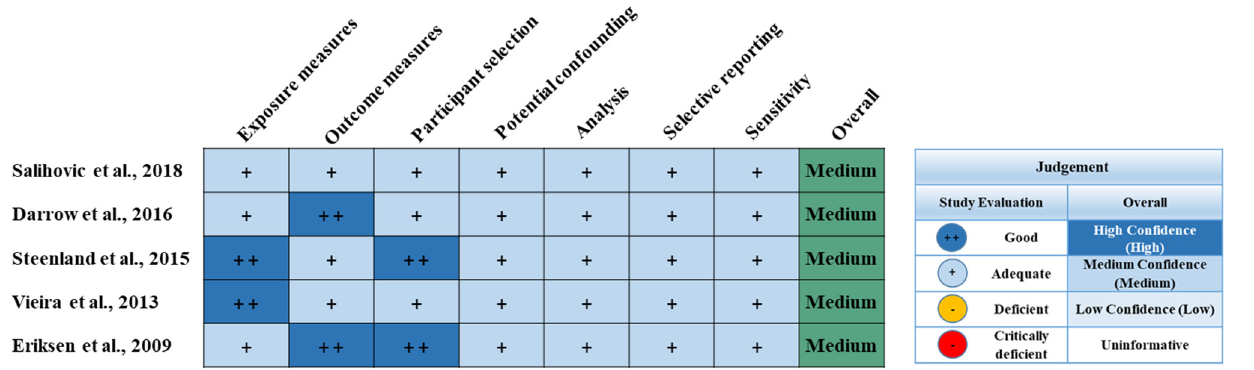
Figure 2. Summary of the risk of bias judgments for each included epidemiology study [15–19].